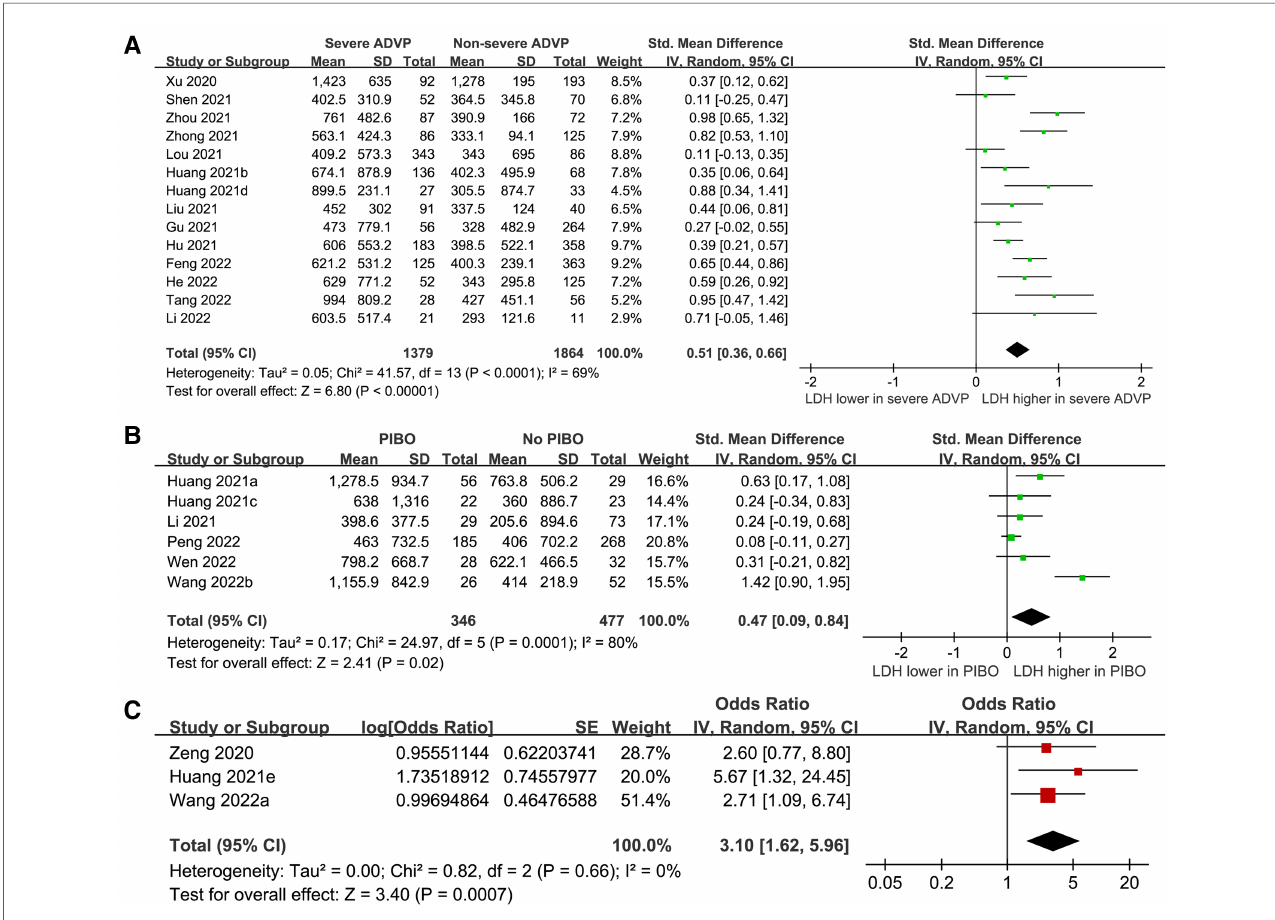
FIGURE 2 Forest plots for the meta-analyses of the role of LDH in children with ADVP. ( A ), meta-analysis for the difference of serum LDH between children with severe and non-severe ADVP; ( B ), meta-analysis for the difference of serum LDH between children who developed and did not develop PIBO; and ( C ), meta-analysis for the association between high LDH (> 500 IU/L) and in-hospital mortality risk in children with ADVP.